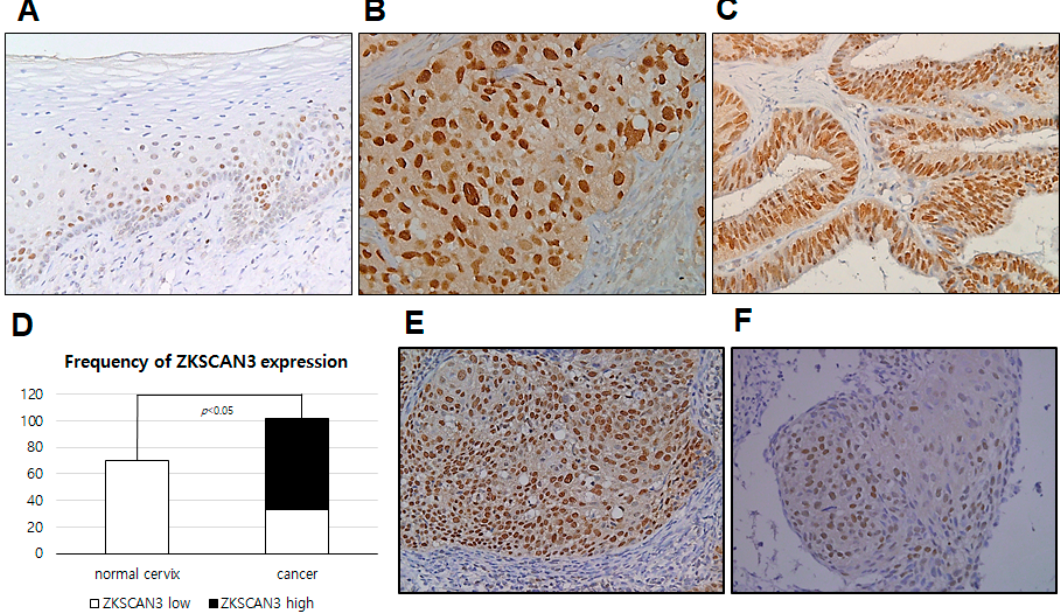
Figure 2. ZKSCAN3 expression in uterine cervical cancer and adjacent non-neoplastic mucosa. ( A ) ZKSCAN3 is rarely expressed in non-neoplastic squamous epithelial cells, except for basal cells. ( B ) ZKSCAN3 is strongly expressed at the nucleus of squamous cell carcinoma of the uterine cervix. ( C ) Cervical adenocarcinoma samples show strong expression of ZKSCAN3. ( D ) Frequency of ZKSCAN3 overexpression between cervical cancers and non-neoplastic cervical mucosae. ( E ) Strong nuclear expression of ZKSCAN3 in squamous cell carcinoma of the cervix. ( F ) Weak expression of ZKSCAN3 in squamous cell carcinoma of the uterine cervix. 200× magnification.